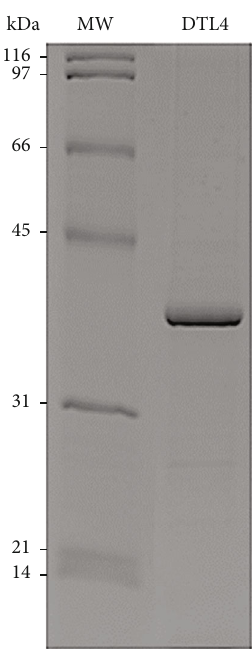
Figure 4: Dodecyl sulfate-polyacrylamide gel electrophoresis analysis of recombinant protein DTL-4. DTL-4 ( ~ 40kDa) was puri fi ed in nickel a ffi nity chromatography and submitted to SDS- PAGE analysis. Molecular weight markers are shown on the